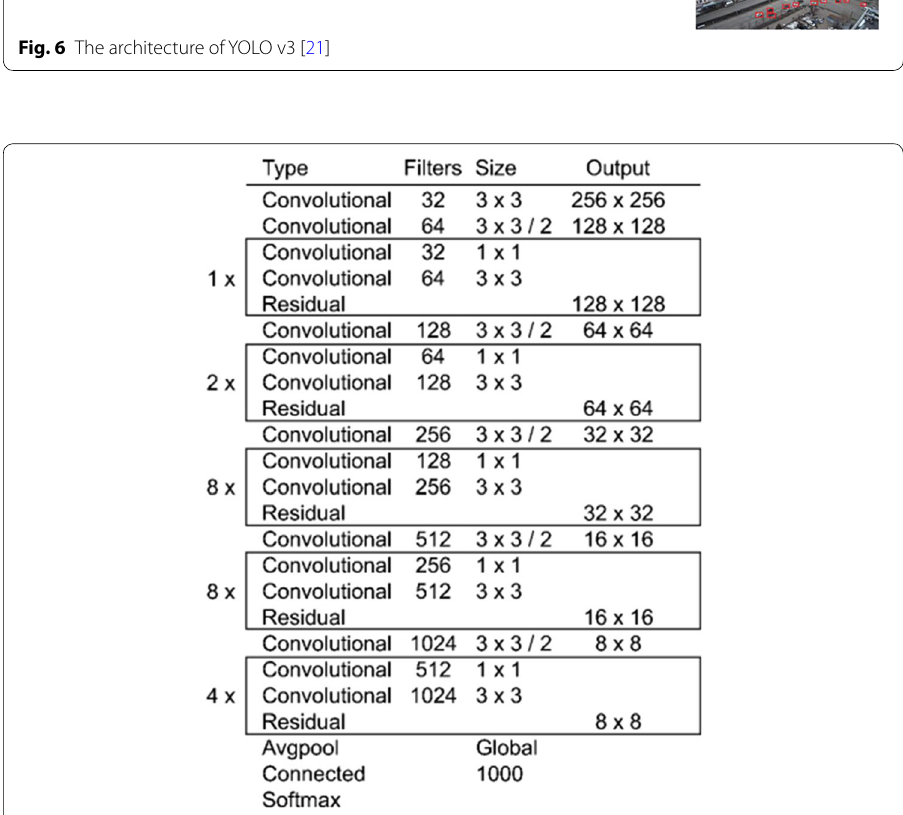
Fig. 7 The architecture of Darknet-53